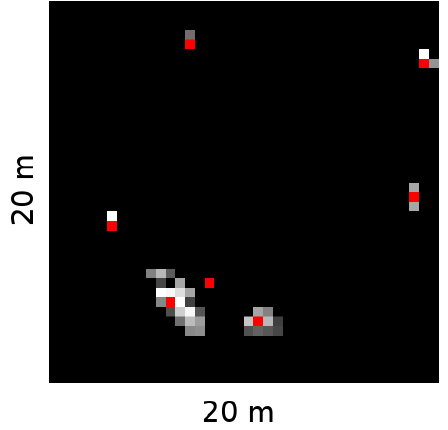
Figure 1. A raster of the stem probability factor in grey scale. The final tree stem positions are marked in